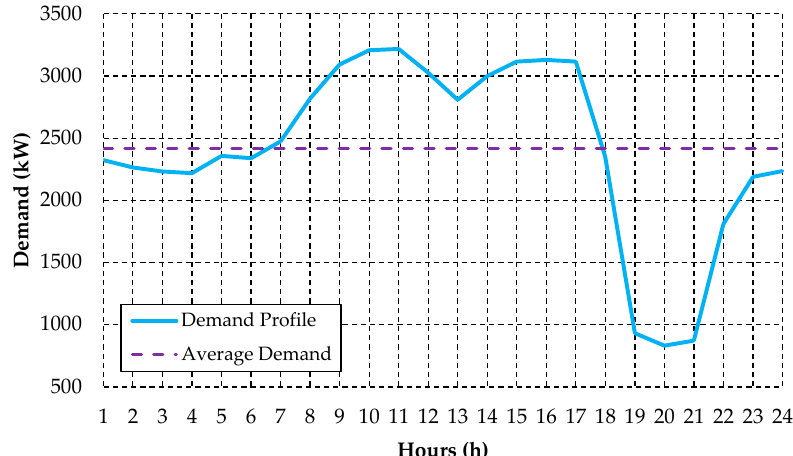
Figure 12. Daily demand profile of the irrigator customer group present at the Rural Feeder A. Source: The authors.